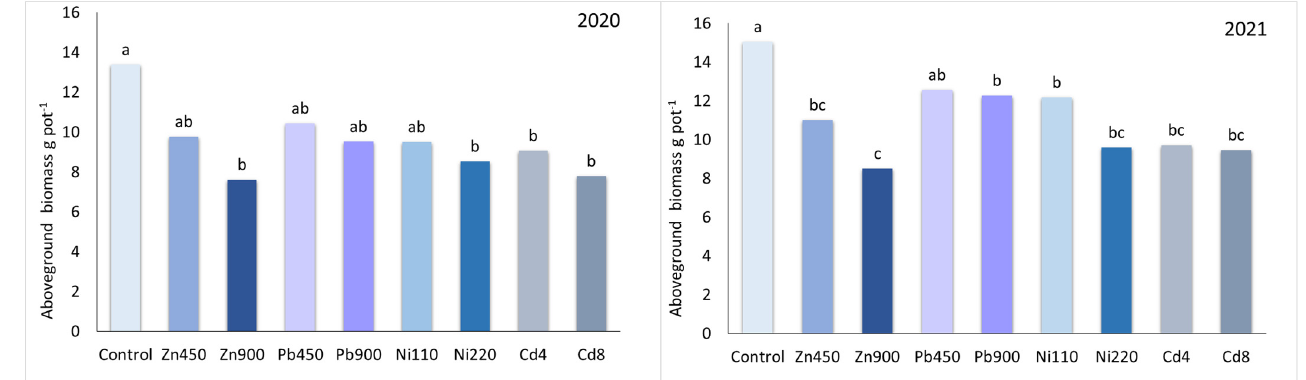
Figure 2. Aboveground DM (g.pot − 1 ) of Safflower concerning the different studied treatments. Values with different letters indicate statistical significance (according to HSD at p ≤ 0.05).